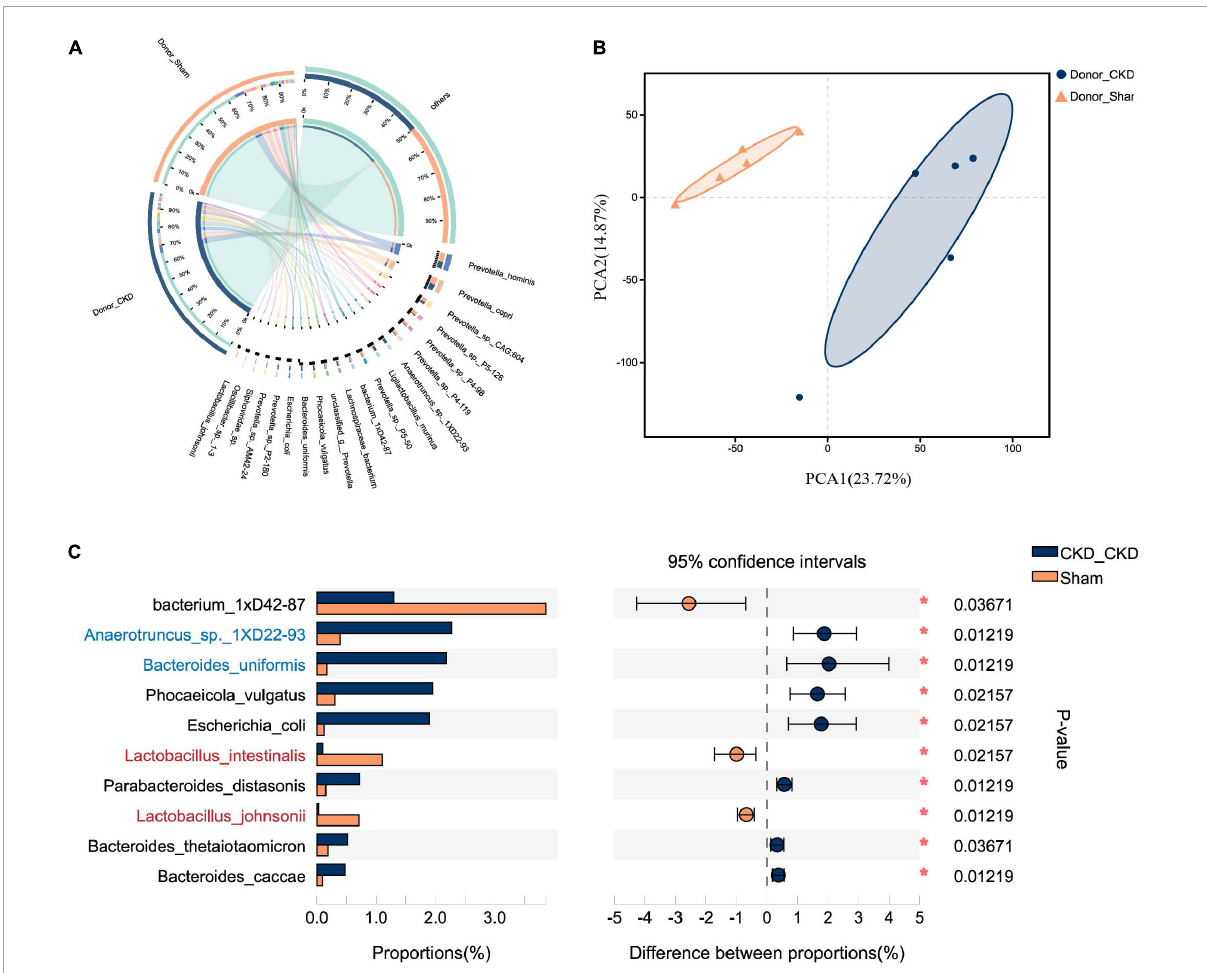
FIGURE3 Differences in gut microbiota between Donor CKD and Donor Sham rats. (A) Circos sample-species relationship map. (B) PCA plots of species-level metagenomic expression (PERMANOVA P < 0.05). (C) Differential microbial species (Wilcoxon rank sum test). The vertical coordinates indicate the species names at different taxonomic levels, and the horizontal coordinates indicate the percentage value of the abundance of a species for that sample, with different colors indicating different groupings. Donor Sham, n = 5; Donor CKD, n = 5. * P < 0.05.